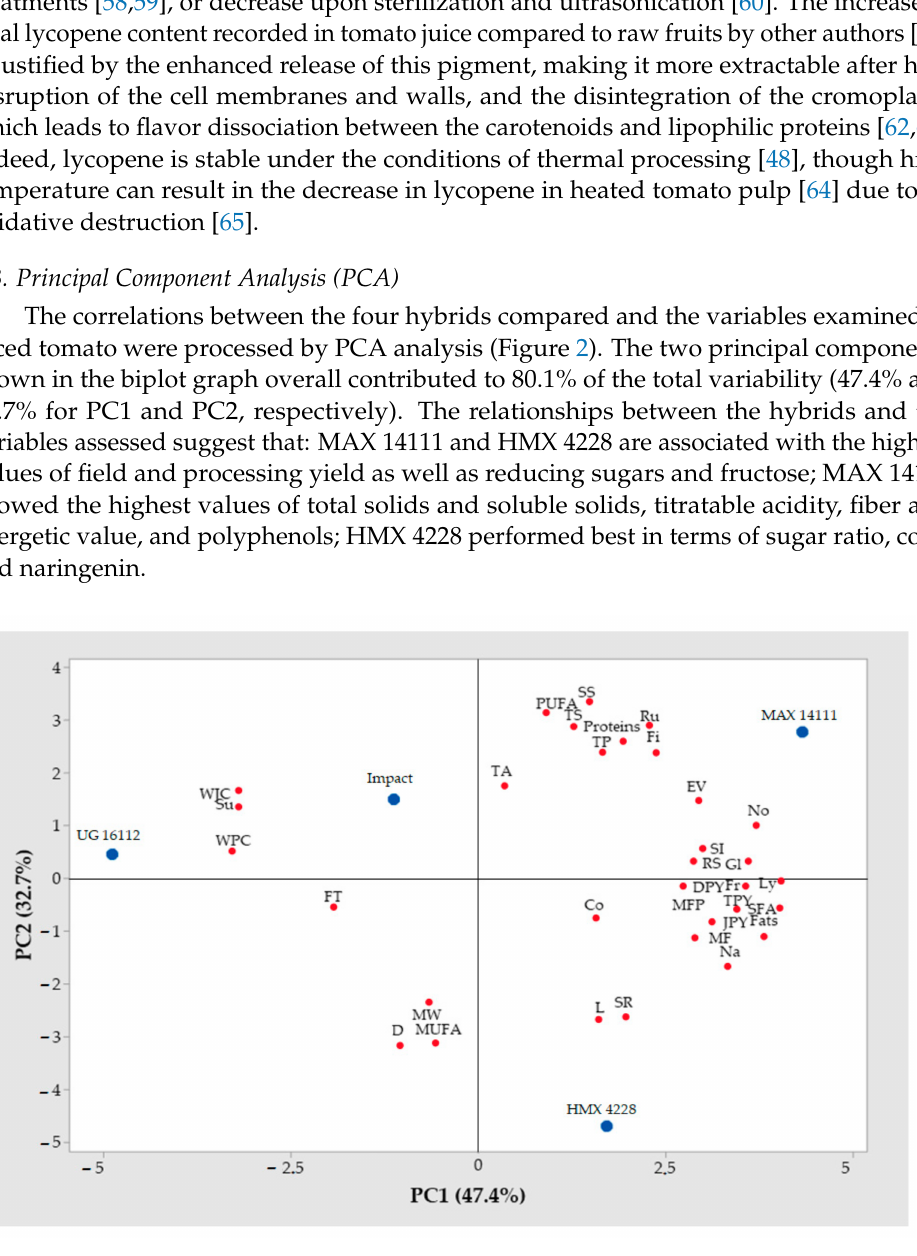
Figure 2. Biplot graph relevant to Principal Component Analysis (PCA). HMX 4228, Max 14111, UG 16112 and Impact are the four hybrids tested (blue circles). The variables examined (red circles) are: Co, color; D, fruit diameter; DPY, diced processing yield; EV, energetic value; Fi, fiber; Fr, fructose; FT, flesh thickness; Gl, glucose; JPY, juice processing yield; L, fruit length; Ly, lycopene; MUFA, monounsaturated fatty acids; MW, mean fruit weight; MF, marketable yield; MYP, marketable yield percentage; Na, naringenin; No, number of fruits per plant; PUFA, polyunsaturated fatty acids; RS, reducing sugars; Ru, rutin; SFA, saturated fatty acids; SI, shape index; SR, sugar ratio; SS, soluble solids; Su, sucrose; TA, titratable acidity; TP, total polyphenols; TPY, total processing yield; TS, total solids; WPC, waste along peeling chain; WJC, waste along juice